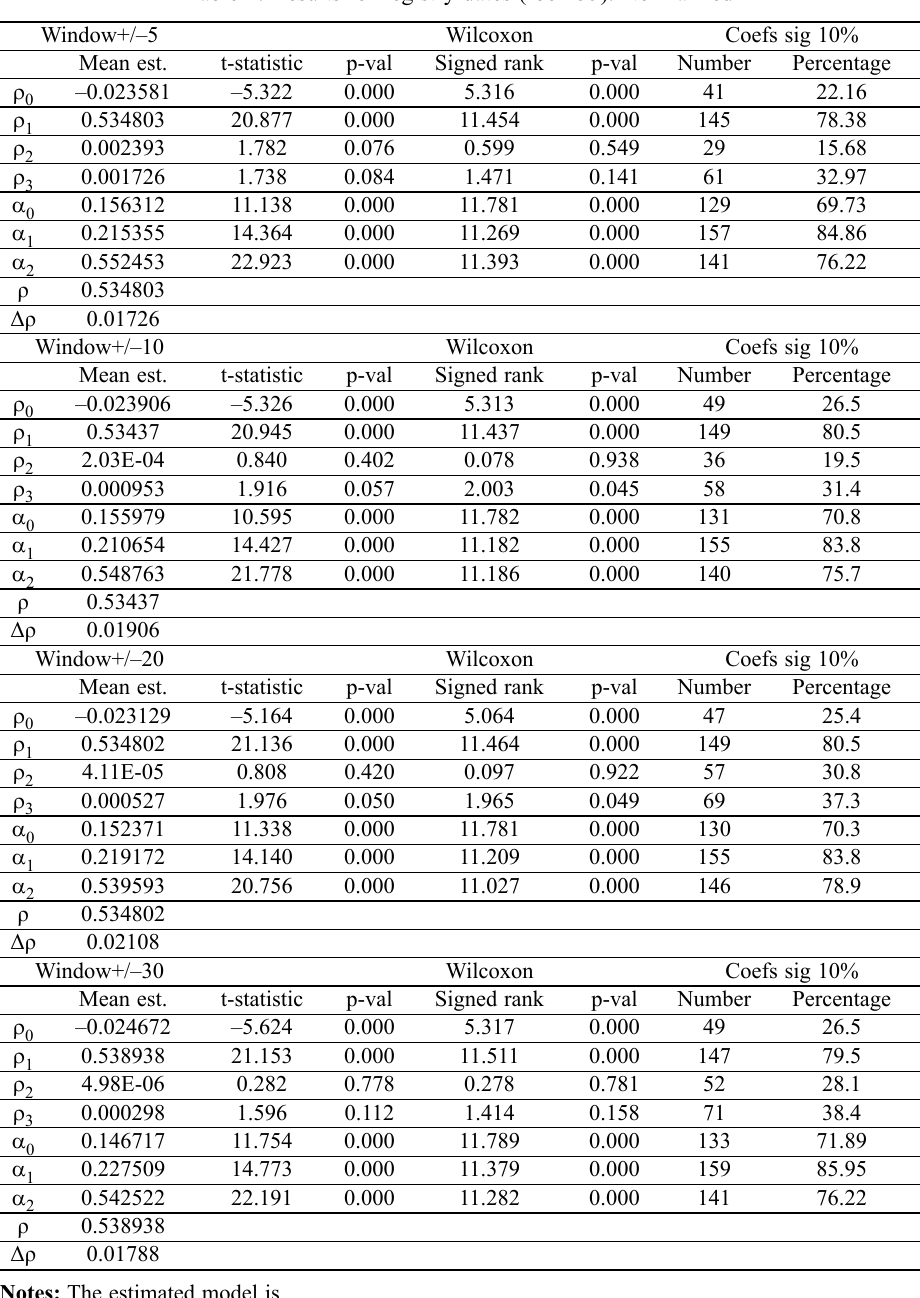
Table 4. Results for registry dates (Ibex-35).